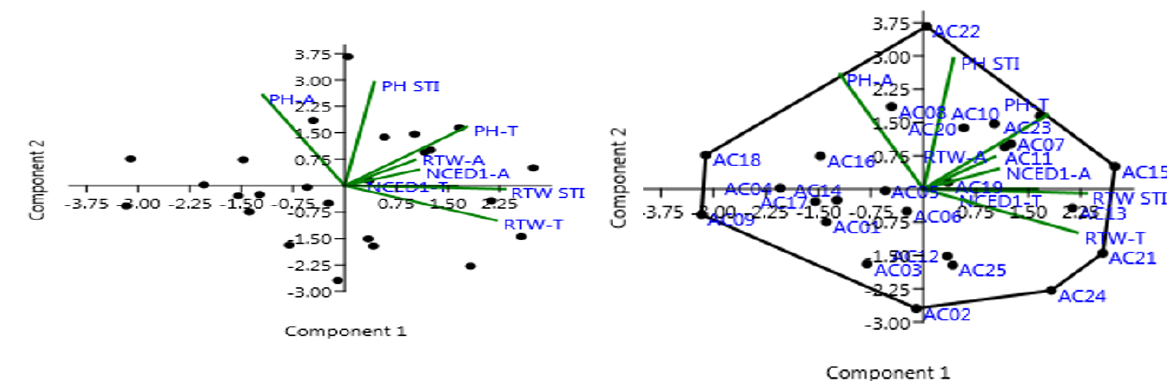
Fig. 3. Bi-plot (a) (showing relationships among traits) and polygon view (b) of Principal Component Analysis (PCA) based on morphological traits, STIs, and expression patterns of NCED1 gene of accessions of cowpea under control (A) and drought stress (T) conditions. AC01-AC25 are accessions of cowpea. PH-A: Plant height under control; PH-T: Plant height under drought stress; RTW-A: Dry root weight under control; RTW-T: Dry root weight under drought stress; PH STI: Stress tolerance index for plant height; RTW STI: Stress tolerance index for dry root weight; NCED1-A : Expression of the gene under control; NCED1-T : Expression of the gene under drought stress.